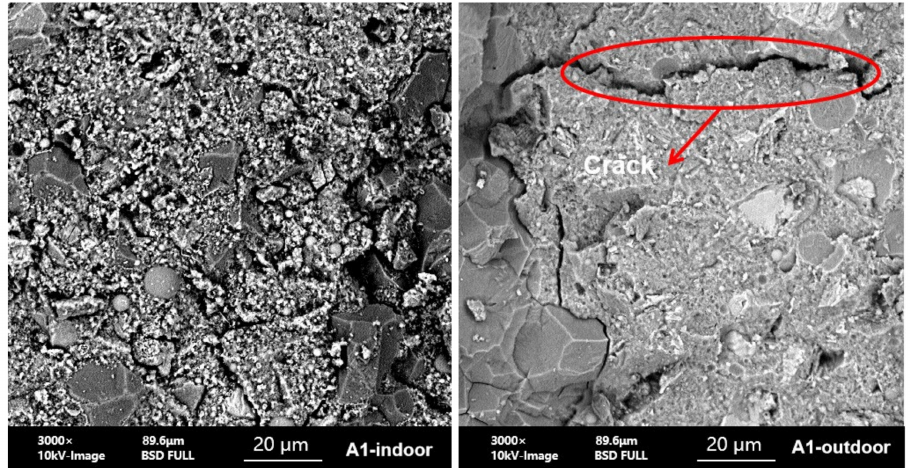
Figure 15. SEM images of UHPC based on composite cementitious material indoor and